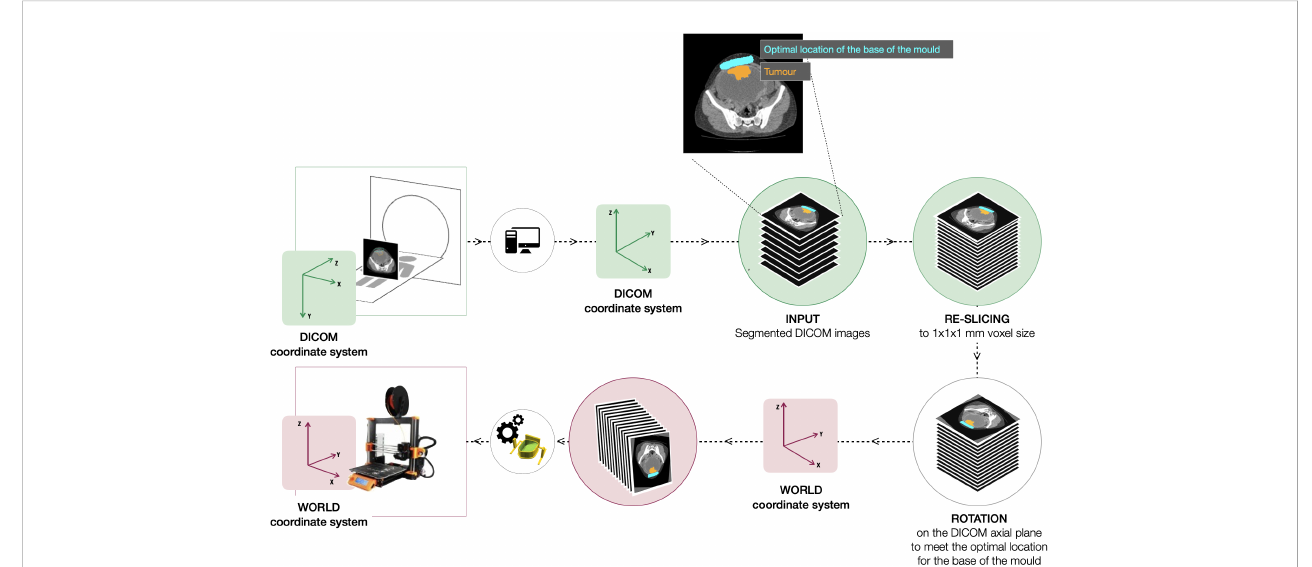
FIGURE 1 Initial steps of the pipeline to re-slice and re-orientate the segmentation to build the mould complying with the imposed base of the mould location (manually segmented, in cyan) and the slicing direction (in the anatomical axial plane). When transforming the image to the world coordinate system (WCS), the slicing direction is perpendicular to the x